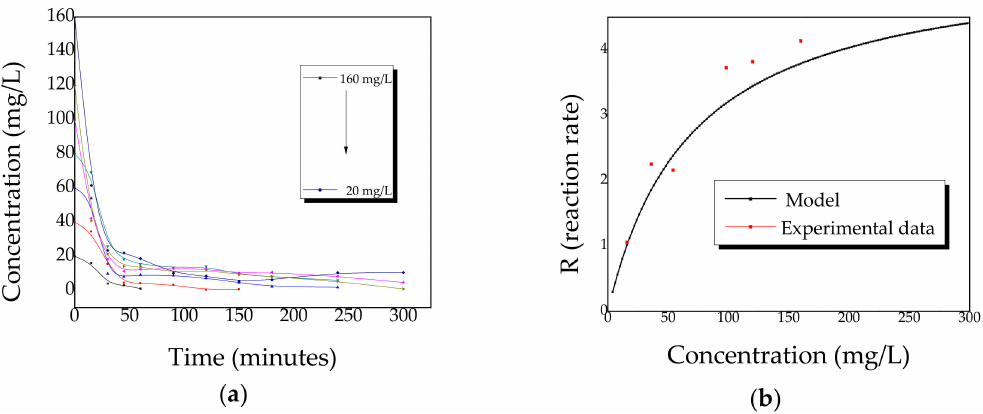
Figure 4. ( a ) nonylphenol polyethylene glycol (NPEG) concentration (mg / L) as a function of time, degradation profile at di ff erent reaction times, (catalyst concentration = 2 g / L, total volume = 250 mL, amount of oxygen = 100 cm 3 / min). ( b ) Estimation of the Langmuir–Hinshelwood (L–H) model applied in the degradation of